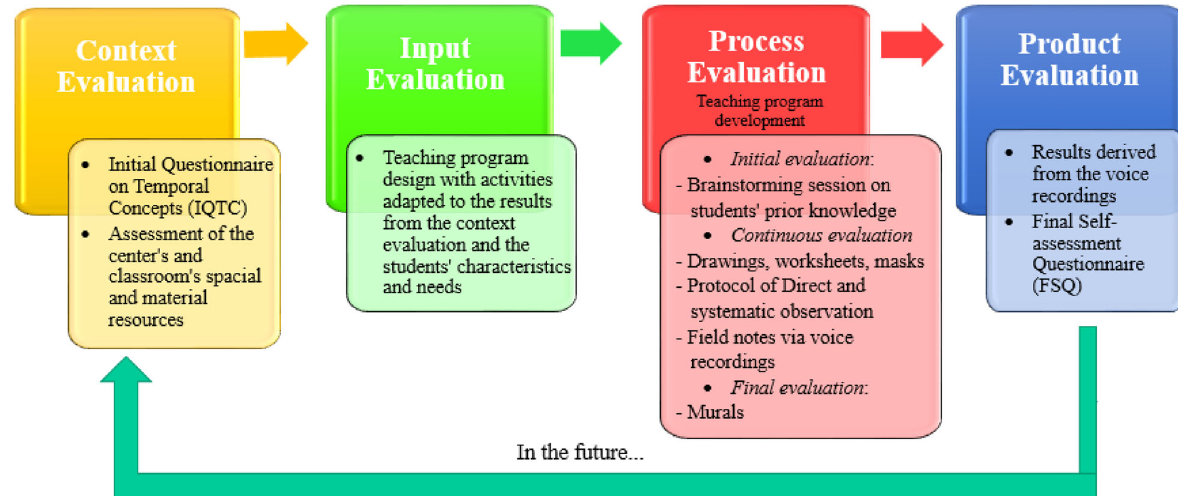
Fig. 1 Mixed methods research design using the CIPP evaluation model. This fi gure shows the steps of the CIPP evatuation model and how in this investigation the steps has been carried